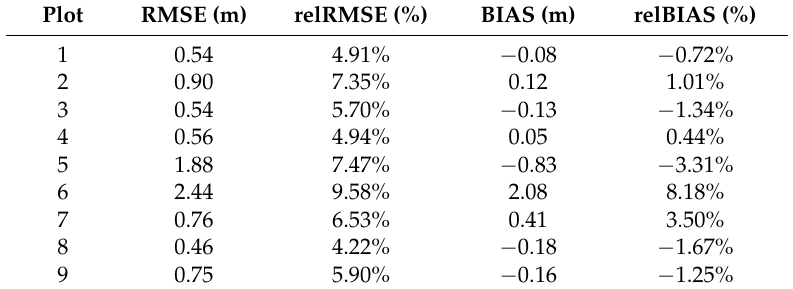
Figure 19. Scatter plot of estimated tree heights. Table 4. Accuracy of the tree height estimations using the SLAM smartphone.